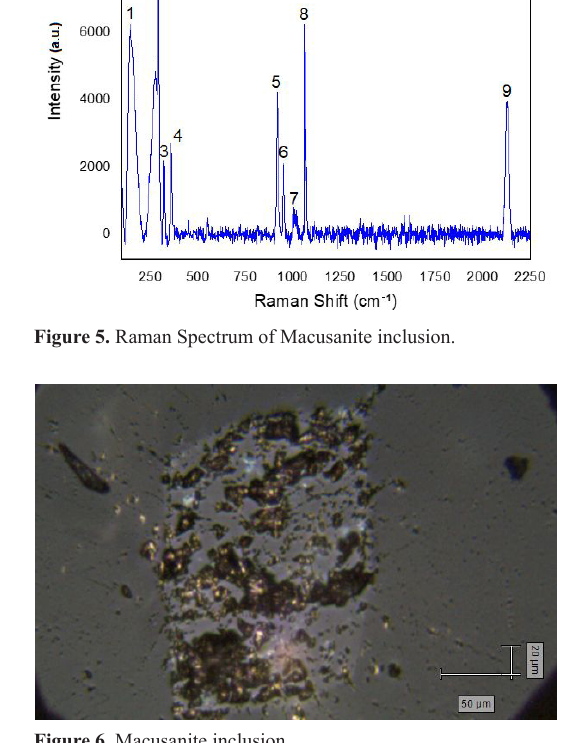
Figure 6. Macusanite